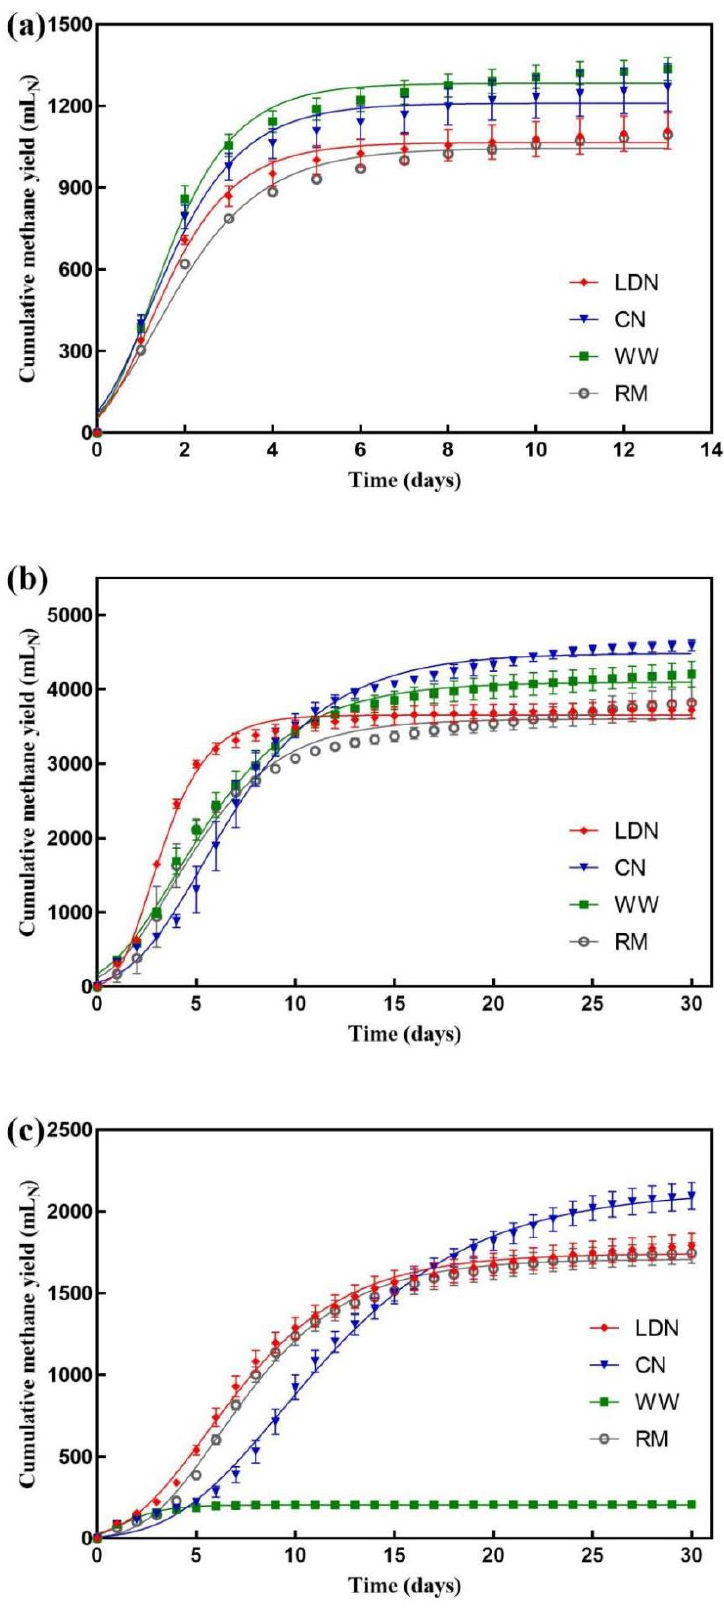
Figure 5. Curve fitting of the Gompertz equation to methane production data for ( a ) BMP, ( b ) L-AD and ( c ) SS-AD tests. Dots denote the means of data and lines denote the Gompertz curves.